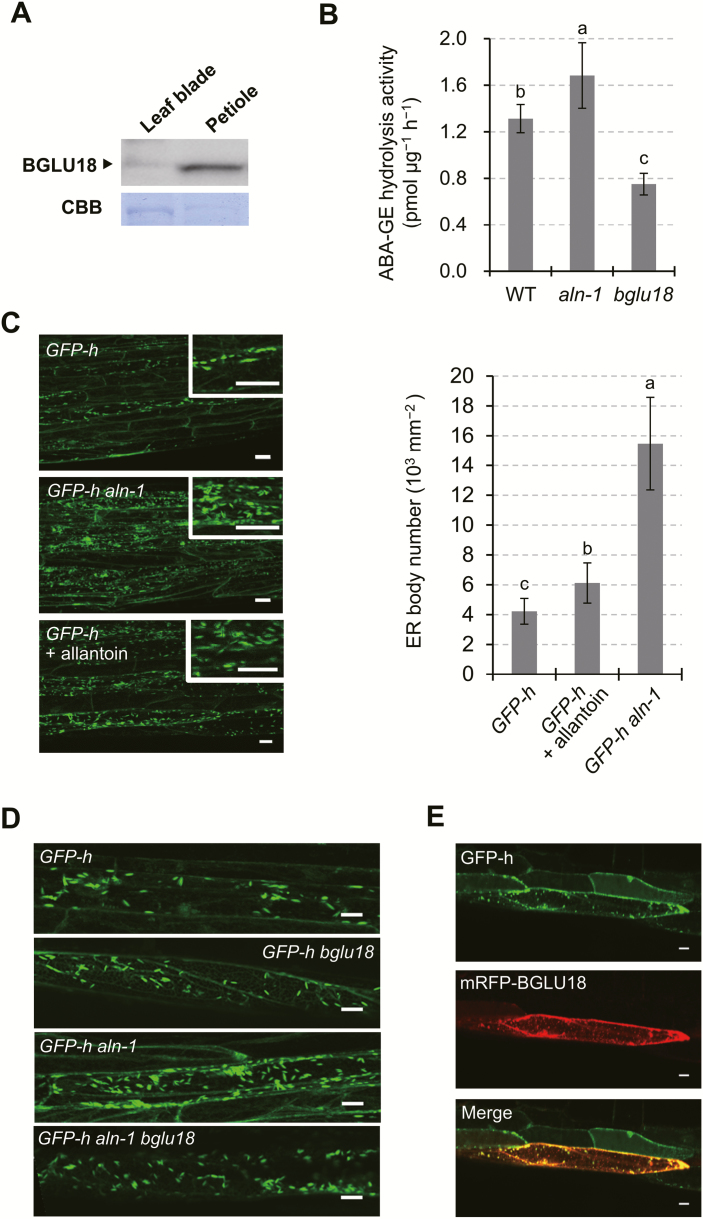
Effects of aln mutation and exogenous allantoin on the ABA-GE activity of BGLU18 and ER bodies in leaf petioles. (A) Distribution of BGLU18 in aln-1 leaf tissue. Immunoblotting was carried out as described in Fig. 1A. (B) ABA-GE hydrolysis activity in WT, aln-1, and bglu18 plants. (C) Representative fluorescence images of leaf petiole epidermal cells in GFP-h (upper), GFP-h aln-1 (middle), and GFP-h plants grown in the presence of 100 μM allantoin (lower). The histogram on the right shows the quantity of ER bodies in leaf petiole epidermal cells. (D) Representative fluorescence images of leaf petiole epidermal cells in GFP-h (uppermost), GFP-h bglu18 (upper middle), GFP-h aln-1 (lower middle), and GFP-h aln-1 bglu18 plants (lowermost). (E) Representative fluorescence images of leaf petiole epidermal cells transiently expressing mRFP-BGLU18 in GFP-h aln-1 plants. Data are means ±SD (n=3 in B; n=5 in C). Different letters indicate a significant difference (P<0.05 by one-way ANOVA). Scale bars=20 μm.